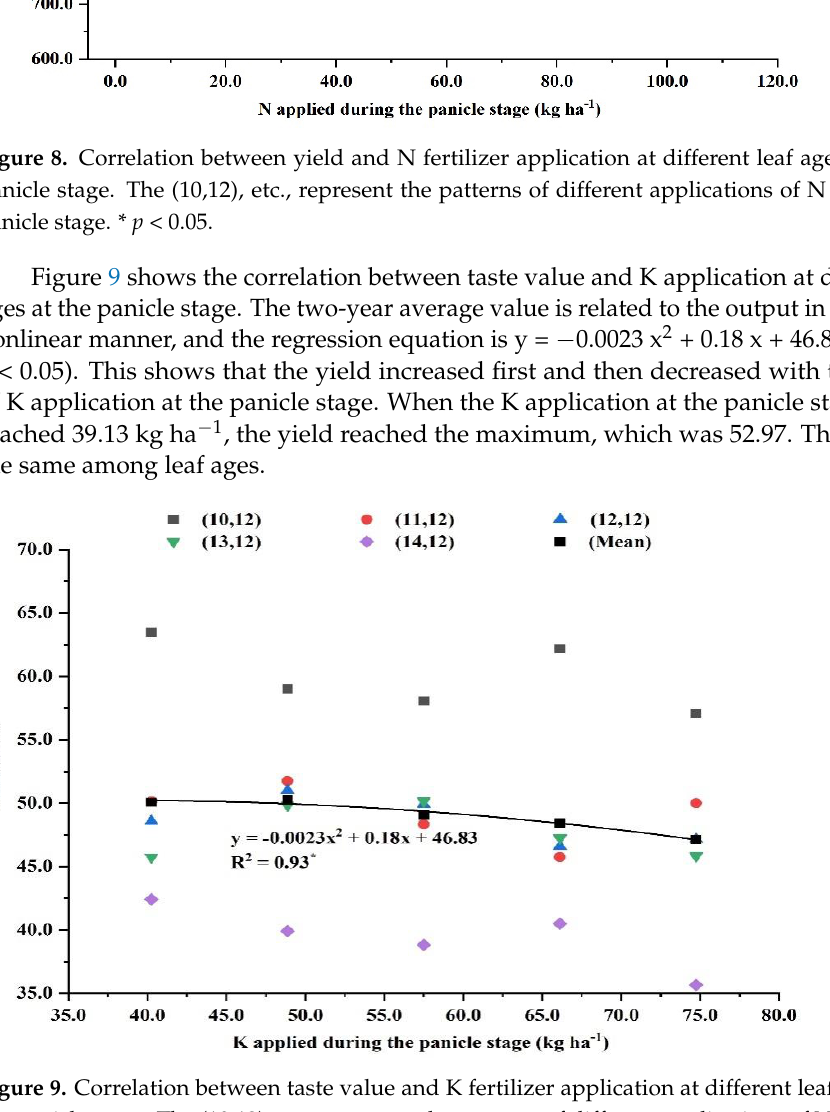
Figure 9. Correlation between taste value and K fertilizer application at different leaf ages during the panicle stage. The (10,12), etc., represent the patterns of different applications of N and K at the the panicle stage. The (10, 12), etc., represent the patterns of different applications of N and K at the panicle stage. * p < 0.05. panicle stage. * p <